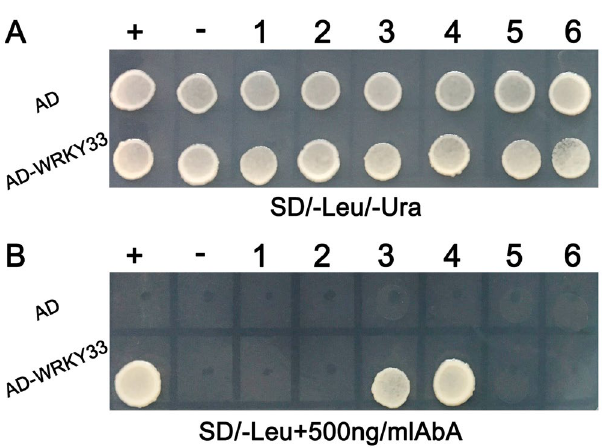
Figure 8. Quantitative RT-PCR analysis of expression of the drought stress-related and ABA-responsive genes in GhWRKY33 transgenic Arabidopsis. Total RNA was isolated from 10-day-old seedlings grown without (CK) or with 250 mM mannitol treatment for 72 h or with 100 μ M ABA treatment for 6 h. Transcript levels of RD29A, DREB2A, ERD15, SOS2, RAB18 and ABI1 in the transgenic lines and wild type were determined by quantitative RT-PCR using AtACTIN2 as a quantification control. Mean values and standard errors (bars) were shown from three independent experiments. One and two asterisks represent there was a significant difference (P < 0.05) and a very significant difference (P < 0.01) in gene expression level between the transgenic lines and wild type, respectively. CK, seedlings grew under normal conditions; Mannitol, seedlings with mannitol treatment; ABA, seedlings with ABA treatment; WT, wild type; L2, L3, L4, three GhWRKY33 transgenic lines.